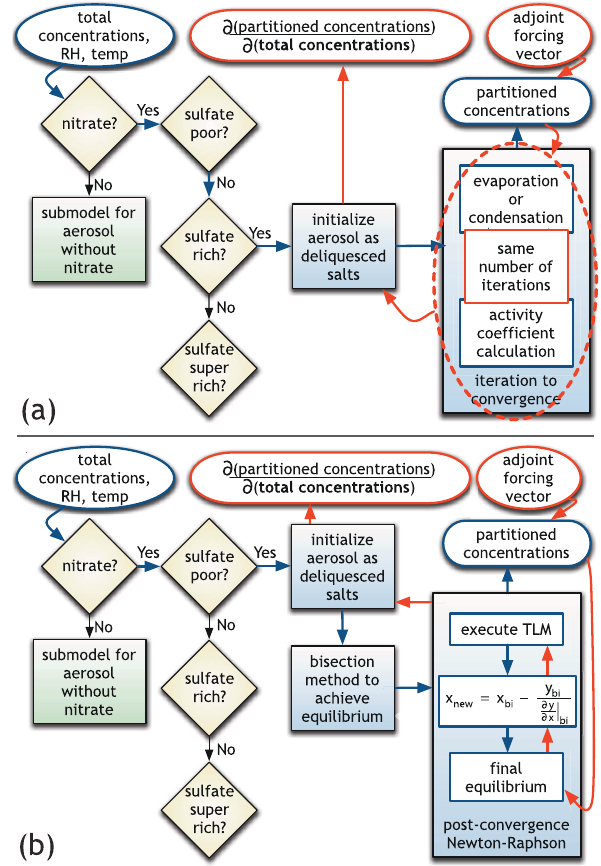
Fig. 1. Algorithmic flowchart of ANISORROPIA forward (blue) and adjoint (red) calculations. (a) The acidic aerosol solution algo- rithm is given for the cases where the molar ratio of positive ions (i.e., total ammonia and sodium) to total sulfate is less than two ( R S < 2); (b) for R S ≥ 2, the neutralized aerosol solution algorithm is